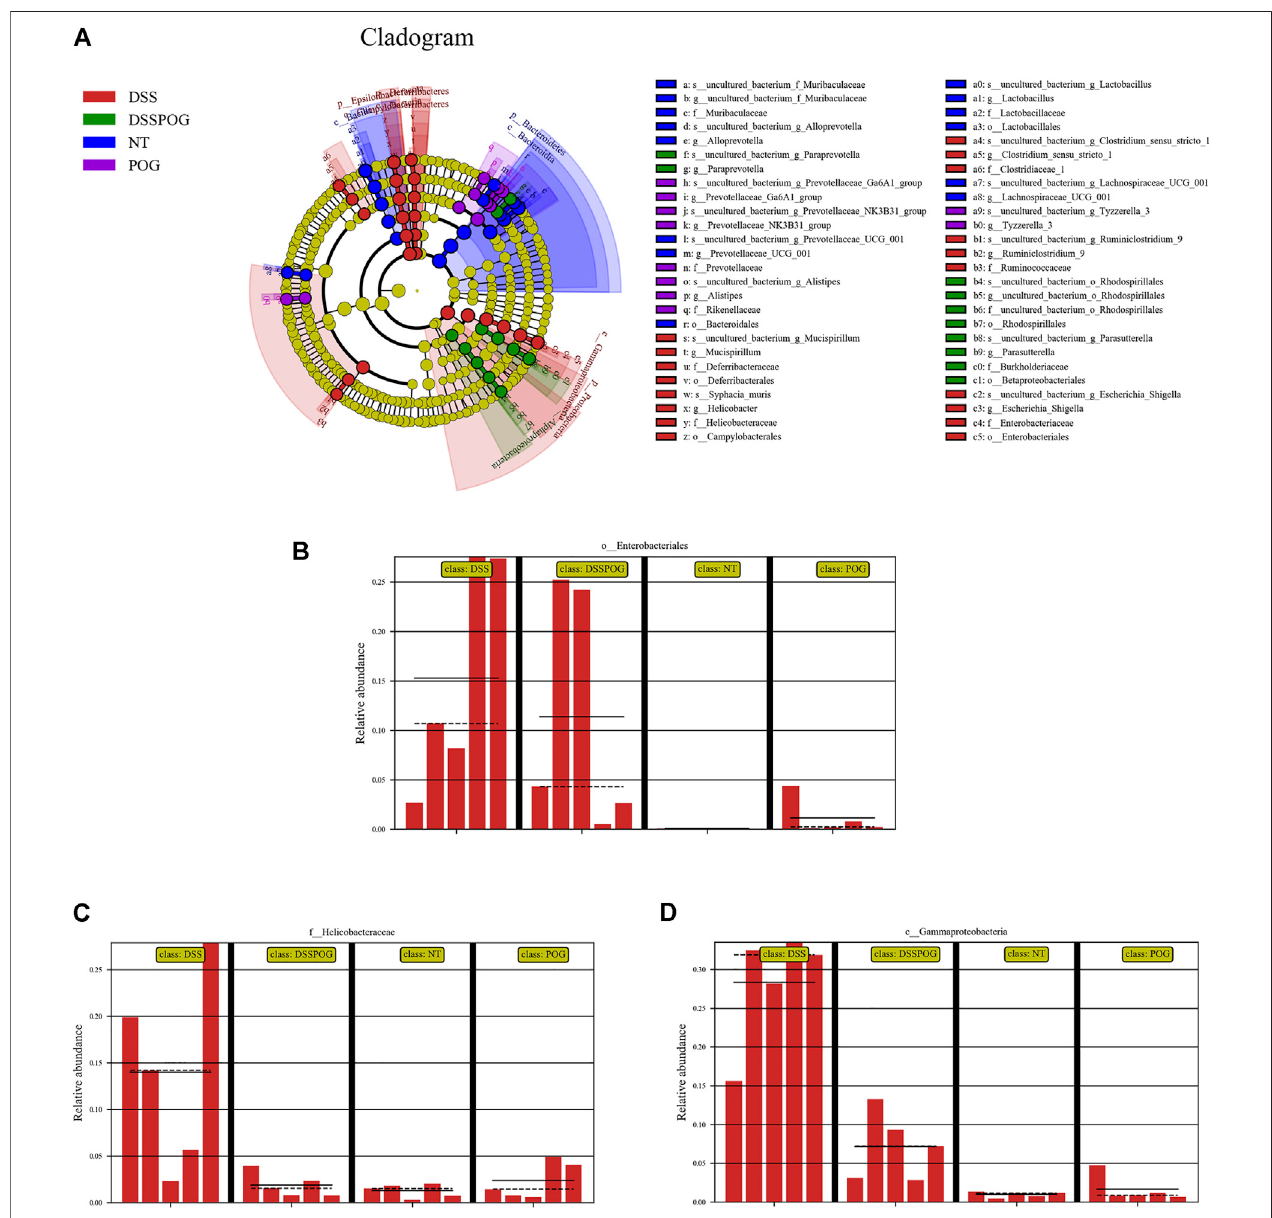
FIGURE 7 | Abundance analysis of the intestinal microbial composition of mice in each group. (A) LEfSe analysis evolutionary branching diagram. (B – D) Relative Enterobacteriales, Helicobacteraceae, and Gammaproteobacteria abundance.